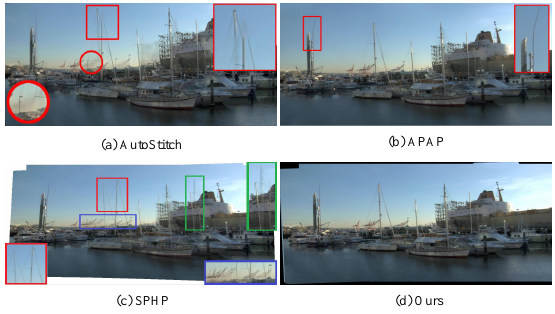
Figure 7. Comparisons among various stitching methods. colored rectangles and their zoom-in rectangles illustrate the false misalignment.